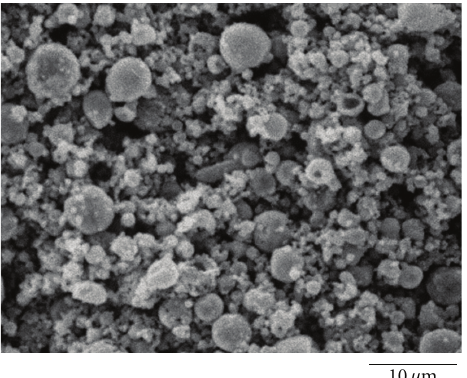
Figure 2: SEM photograph of as-prepared LiNi 0 . 5 Mn 1 . 5 O 4 powders.